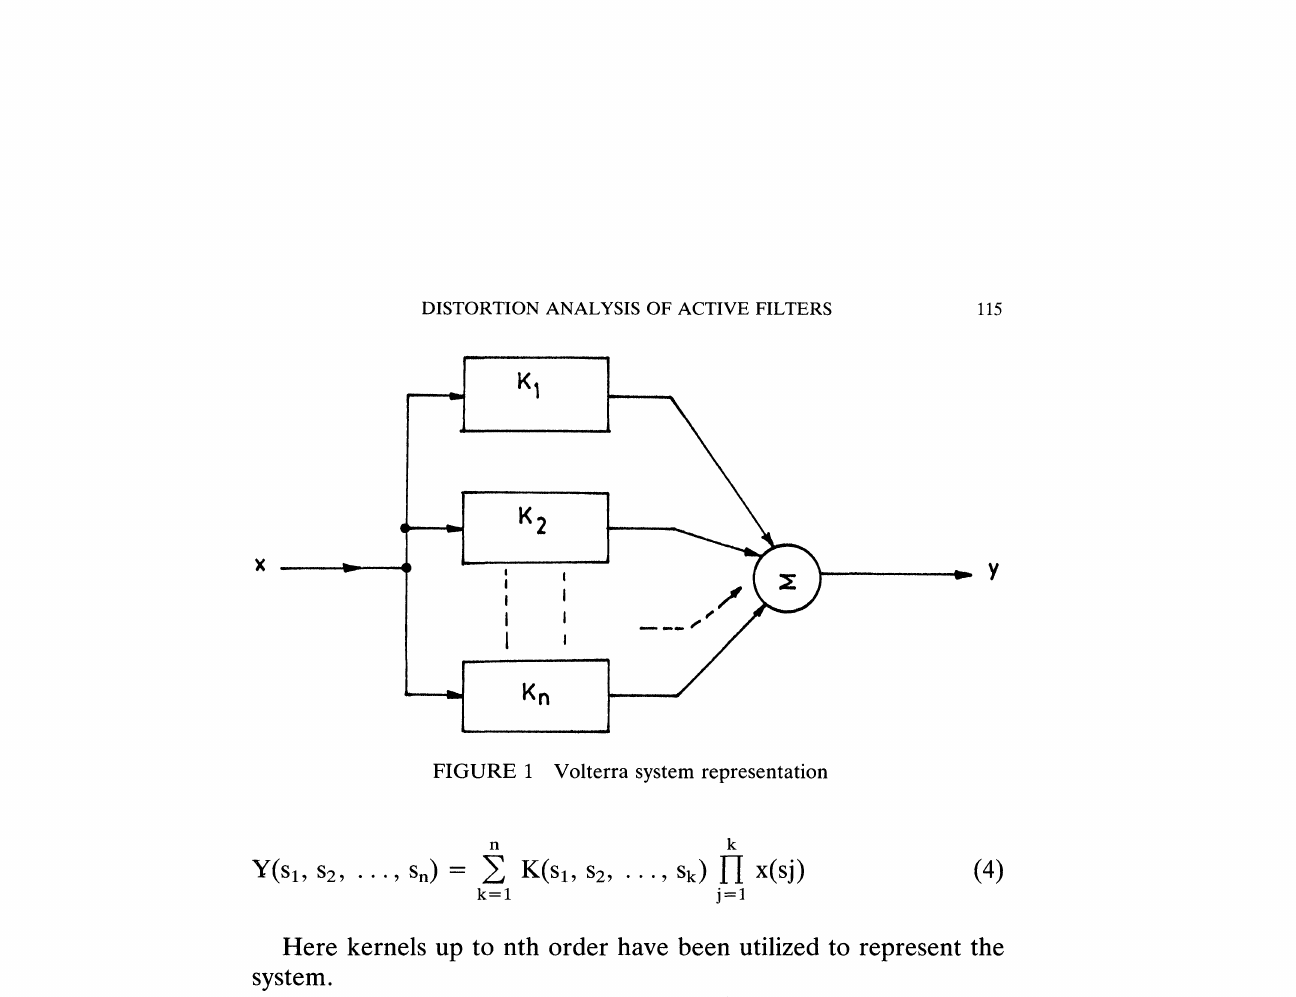
FIGURE Volterra system representation